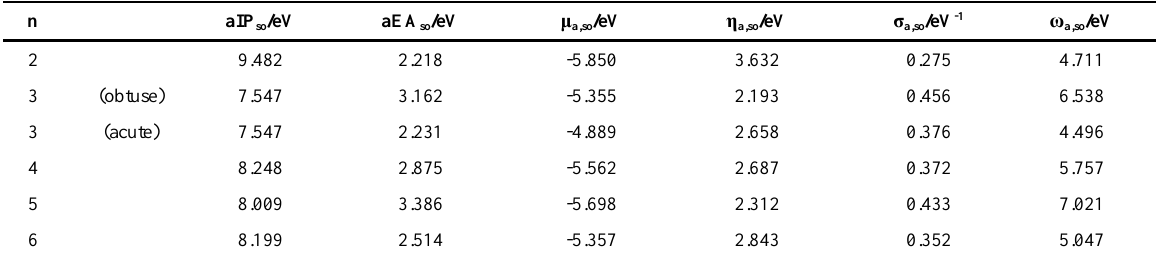
Table 5. Spin-obit corrected adiabatic ionization potential (aIP so /eV), adiabatic electron affinity (aEA so /eV), adiabatic chemical potential (μ a,so /eV), adiabatic hardness (η a,so /eV), adiabatic softness (σ a,so /eV -1 ) and adiabatic electrophilicity index (ω a,so